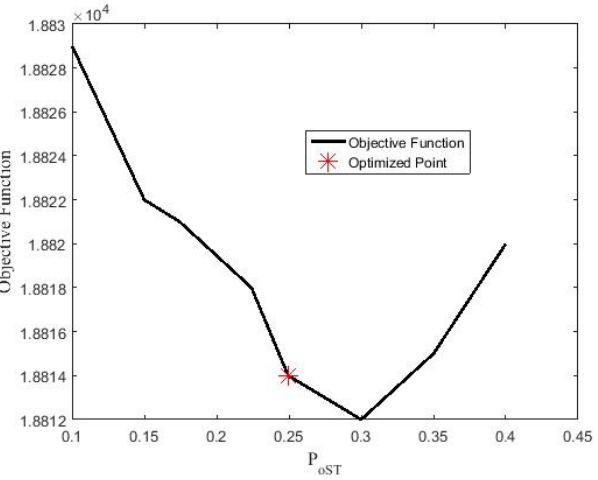
Figure 7. Variations in the objective function with the steam flow rate of the MP.